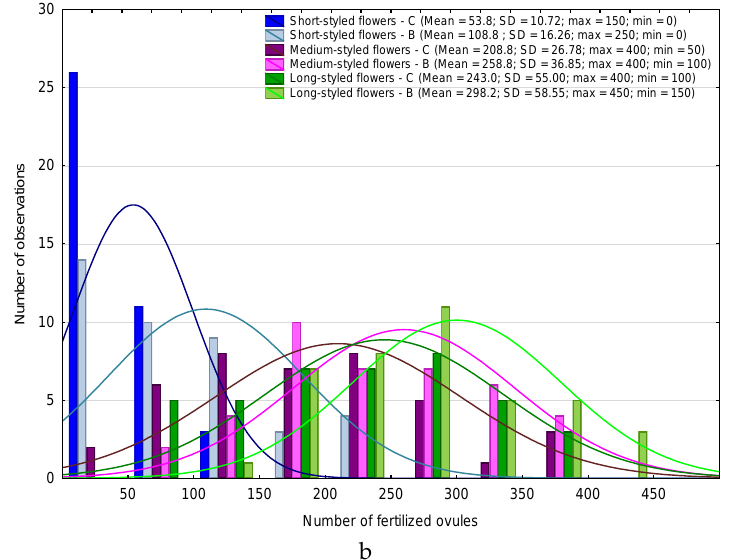
Figure 7. Number of pollen tubes ( a ) and fertilised ovules ( b ) in the styles of different flower types in “Flavine” F 1 .